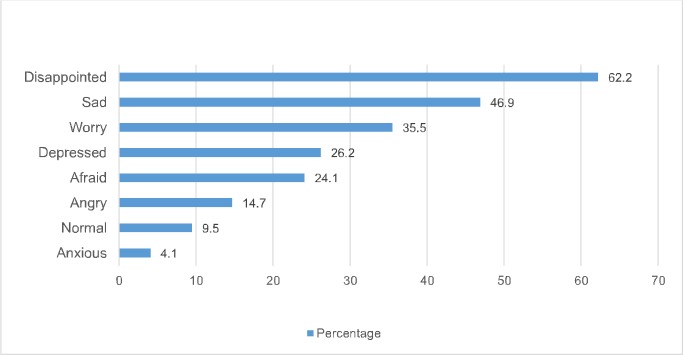
Respondents’ emotional responses in the event of a sero-discordant pre-marital HIV test result (n = 1,406).Note: Percentages are weighted and the total may sum up to more than 100% as multiple responses were permissible.